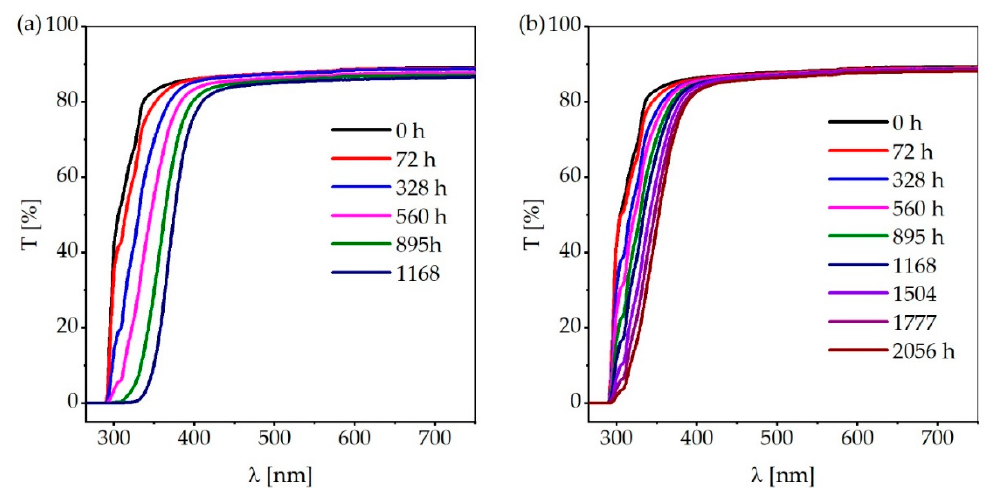
Figure 10. Mean value of the transmission spectra of PC samples at different aging times: ( a ) samples stored at the center of the test chamber; and ( b ) samples stored at the rim of the test chamber.